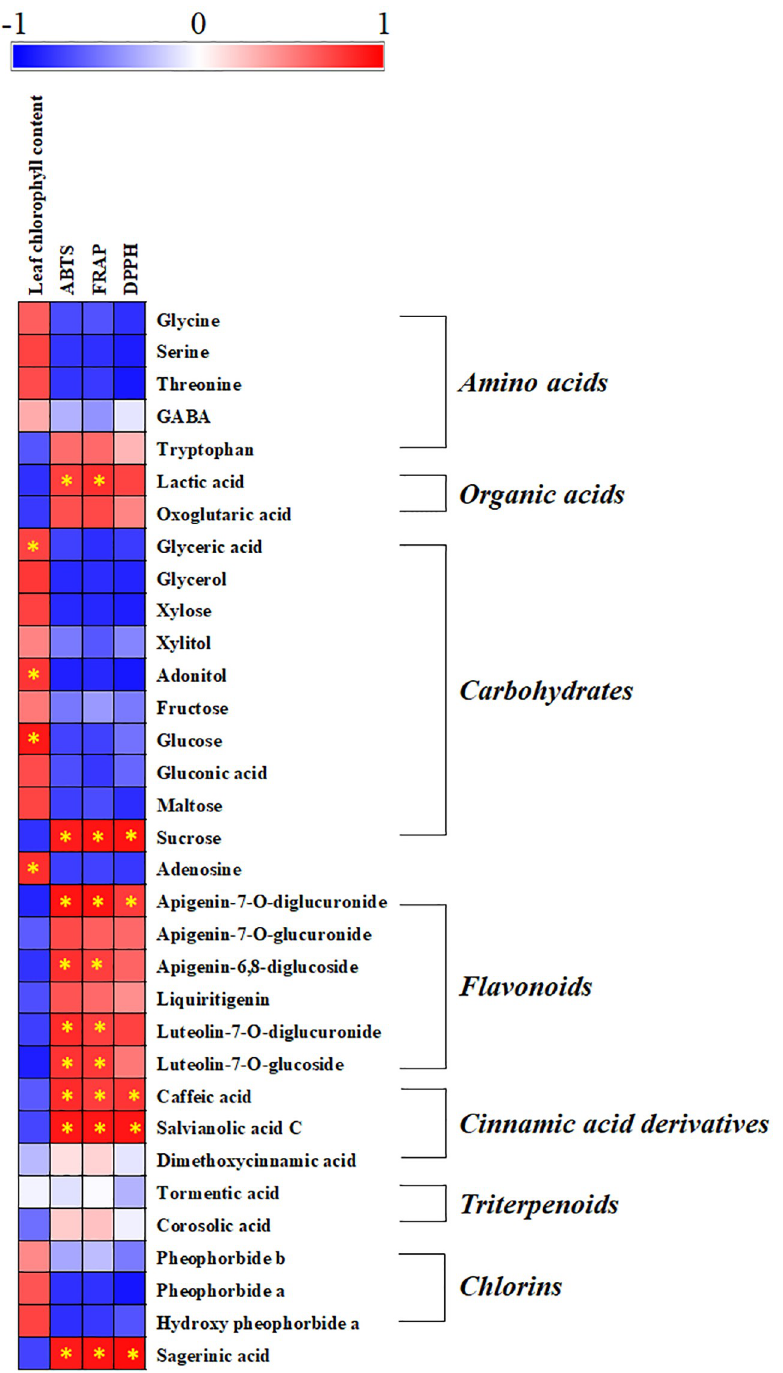
Fig 3. A correlation map for the significantly different metabolites and physicochemical parameters (leaf chlorophyll content, ABTS, FRAP, and DPPH) of Perilla frutescens under control and magnesium oversupply. Each square indicates the Pearson’s correlation coefficient values (r) for a pair of metabolites and physicochemical parameters. The red color indicates positive (0 < r < 1) correlation, and the blue color indicates negative ( − 1 < r < 0) correlation. The asterisks indicate strong positive correlations between metabolites and physicochemical parameters (r > 0.75).